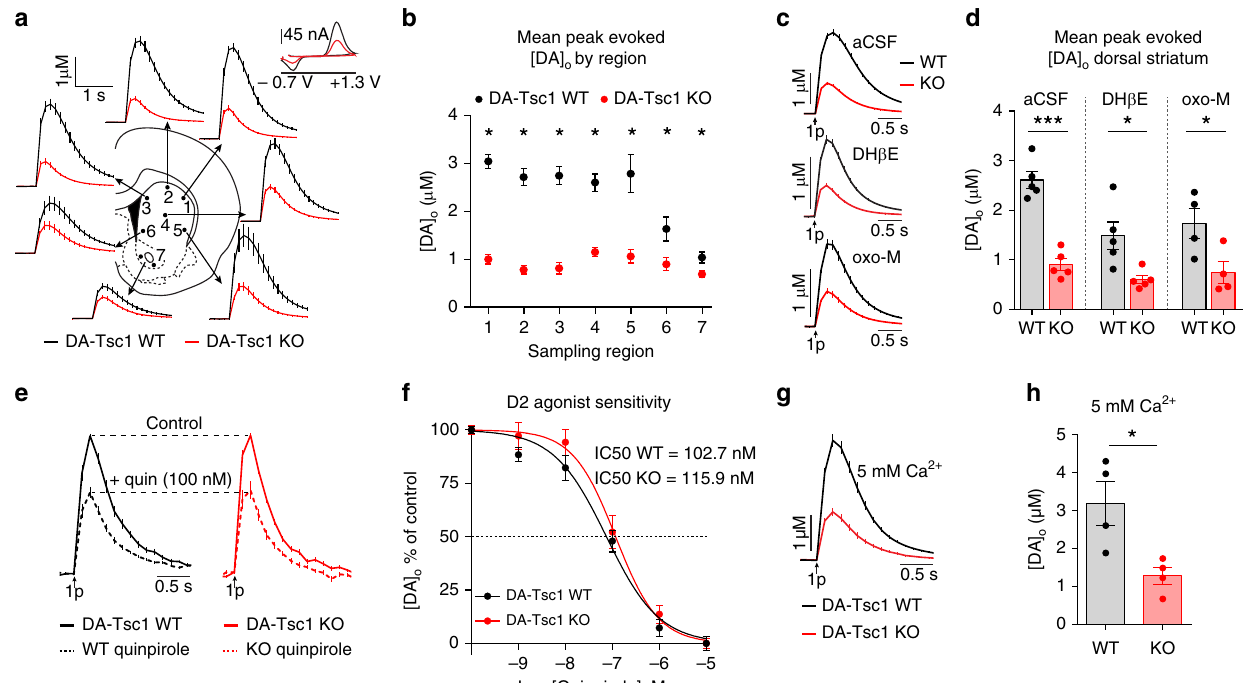
Fig. 3 Loss of Tsc1 impairs striatal DA release. a Mean± SEM [DA] o versus time evoked from different striatal subregions by a single electrical pulse. Traces are an average of 16 – 36 transients per site from fi ve mice per genotype. Inset, typical cyclic voltammograms show characteristic DA waveform. b Mean ± SEM peak [DA] o by striatal region (numbers correspond to the sites in a ). n = 16 – 36 transients per site from fi ve mice per genotype. * p 1 – 4 <0.0001; * p 6 = 0.0067, paired two-tailed t tests; * p 5 = 0.0002; * p 7 = 0.0175, Wilcoxon ’ s two-tailed t tests. c Mean ± SEM [DA] o versus time averaged across all dorsal striatum sites (sites #1 – 6) recorded in aCSF (average of 100 transients across six recording sites from fi ve mice per genotype), 1 μ M DH β E (average of 118 – 122 transients across six recording sites from fi ve mice per genotype), or 10 μ M oxotremorine-M (oxo-M, average of 86 – 88 transients across six recording sites from four mice per genotype). d Mean± SEM peak [DA] o averaged across all dorsal striatum sites (sites #1 – 6) recorded in aCSF ( n = 5